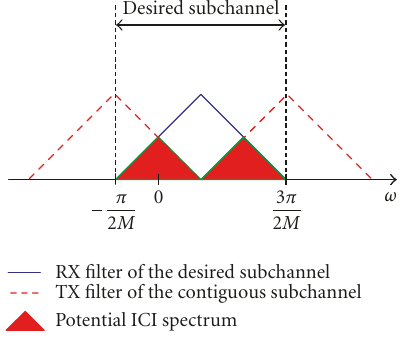
Figure 3: Potential ICI spectrum for subchannel k =